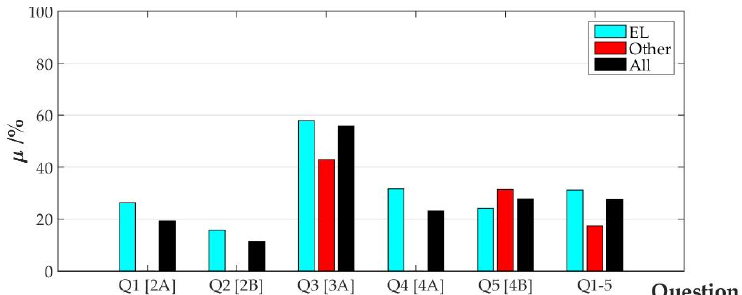
Figure 7. Prior-knowledge test results by track study: μ = mean value; EL = Electronics study track; Other = other study tracks.